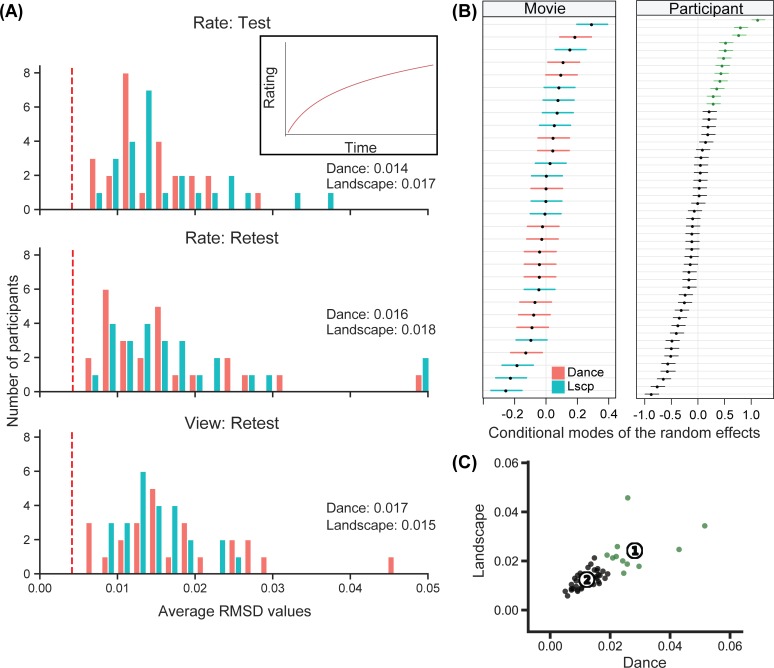
Temporal variability in the continuous ratings.(A) Distributions of mean rmsd values for participants are quite similar across sessions and categories and generally higher than the rmsd value obtained from monotonic increase (inline panel) over the entire clip (red dashed lines). (B) 95% prediction intervals for the random effect estimates of 30 movie clips and 50 participants show that the amount of temporal variability differed more across participants than movies. (Note different x-axes scales for panels.) (C) K-means clustering analysis with median rmsd values resulted in 2 different clusters of participants (shown with green and black). Note that the participants in the first cluster (green-fast responders) have the highest random effects conditional modes.